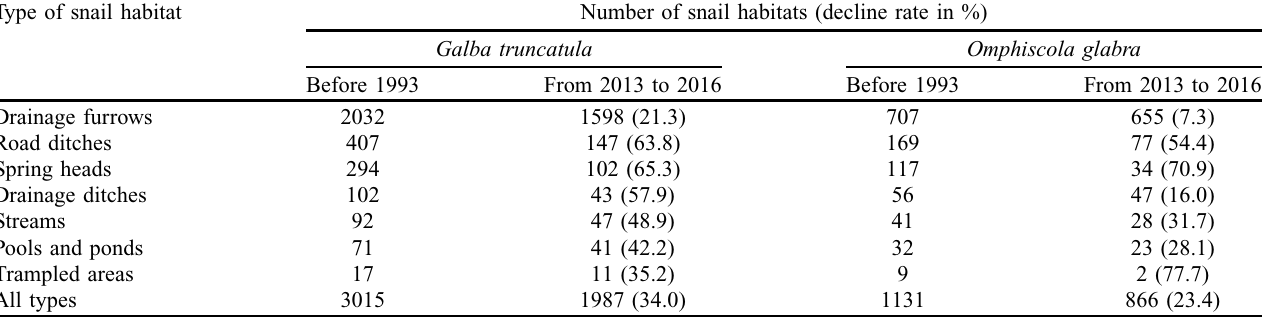
Table 2. Number of snail habitats colonized by Galba truncatula and Omphiscola glabra on the 162 farms before 1993 and in 2013–2016 in relation to their